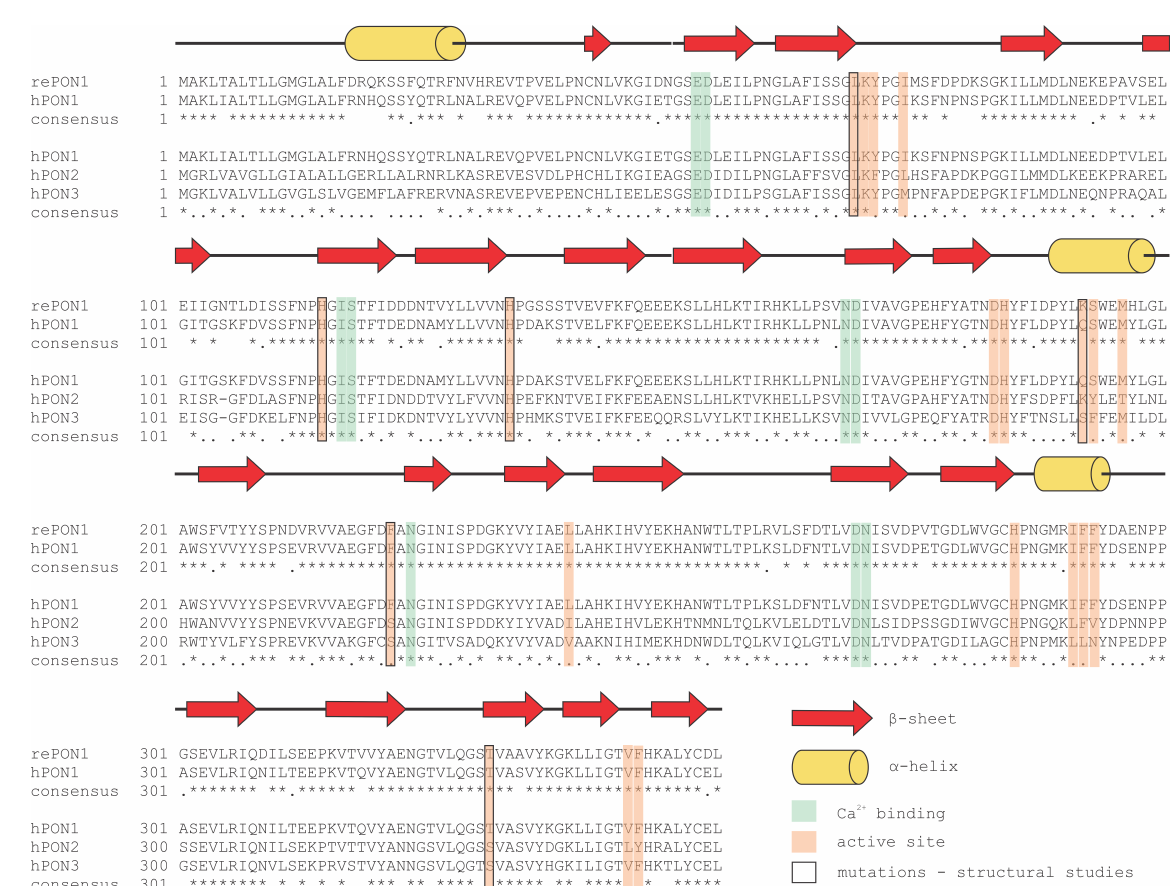
Figure 6. Sequence alignment of recombinant PON1 (rePON1) and human PON1 (hPON1). The rePON1 protein sequence used for structural studies is from the protein database—PDB id: 1V04. The hPON1, hPON2, and hPON3 sequences are from the UniProt database—P27169, Q15165, and Q15166, respectively. In consensus line ( * ) is annotating conserved sequence, ( . ) is annotating conservative mutations and ( ) is annotating nonconservative mutations. Multiple sequence alignment was performed by T-Co ff ee, and Boxshade was used for alignment presentation. Secondary structure annotation, Ca 2 + binding sites (both structural and catalytic ion), and active site residues are adapted from (as marked by di ff erent colors) [28]. The point mutations that were also evaluated by structural studies are annotated according to PDB id sequences: 4HHO, 4HHQ [46], 4Q1U [47], 6G82, 6GMU, and 6H0A